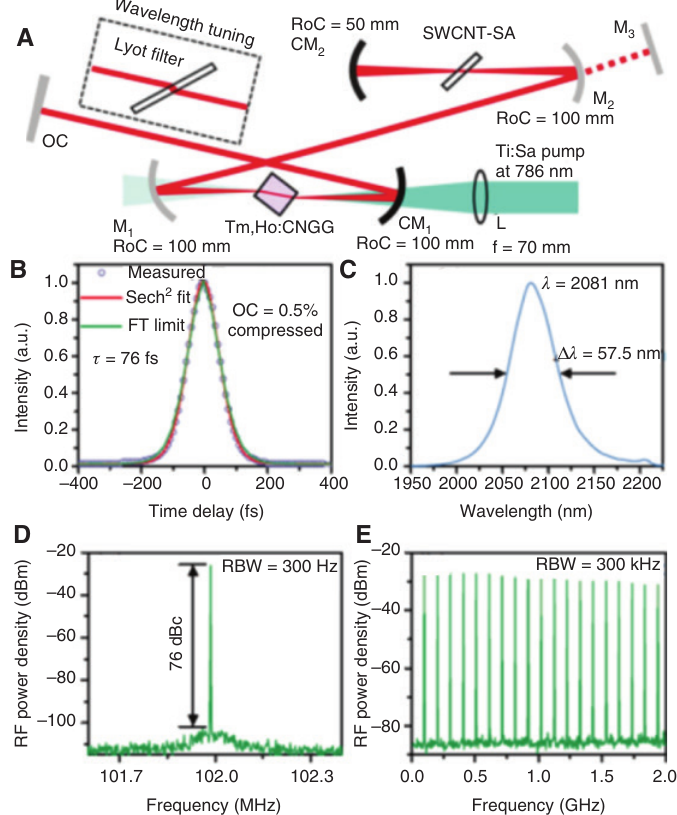
Figure 15: (A) Schematic setup for SWCNT SA mode-locked Tm,Ho:CNGG laser. (B) The ACF with sech 2 fitting. (C) The output optical spectrum of the laser. (D) RF spectra at the fundamental frequency and (E) in a span of 2 GHz. Pan et al. [240]. © Optical Society of America 2018.